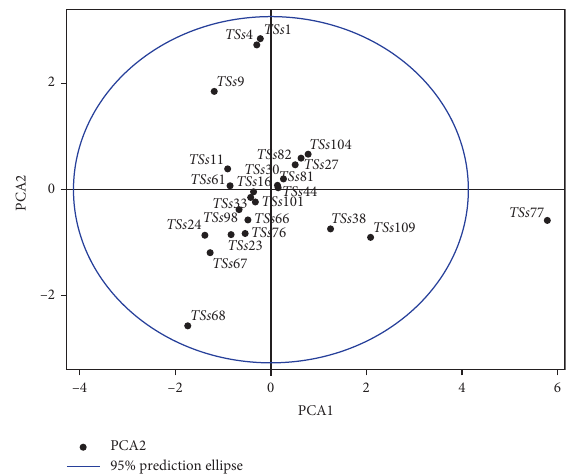
Figure 2: Multivariate analysis based on proximate contents of unprocessed samples. PCA: principal component axis; TSs: Tropical Sphenostylis stenocarpa